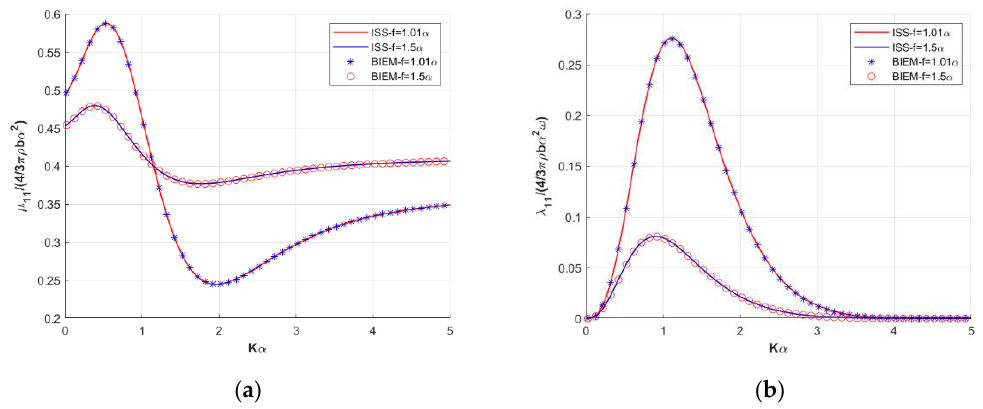
Figure 3. Normalized hydrodynamic coefficients in surge for 𝑎/𝑏 = 1.25 : ( a ) Surge added mass; ( b ) Surge hydrodynamic damping.